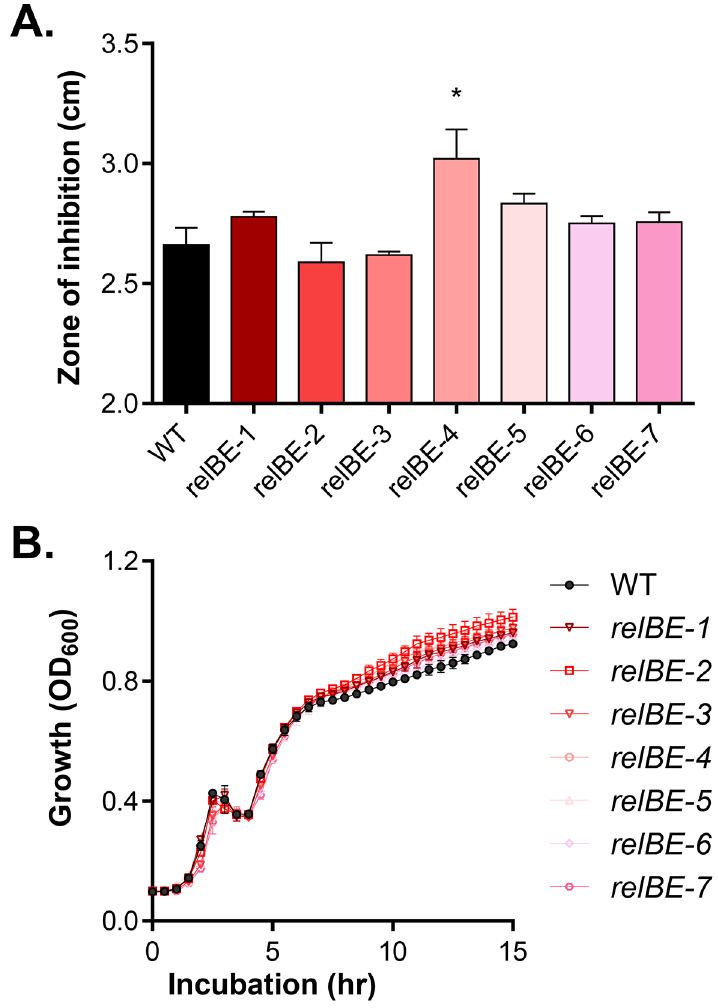
Fig 3. The effect of RelBE on V . cholerae resistance of stress. A. Disc assays for hydroperoxide resistance. Plates with indicated mutant in top-agar were incubated with a disc loaded with (5 M H 2 O 2 ) at 37°C for 16 hrs. The diameter of inhibition zone was then measured. Data are mean and s.d. of three independent experiments. * : P < 0.05. B. Bile resistance. Wild type and relBE mutants were inoculated 1:100 into LB containing 0.02% crude bile (Sigma, Co) and incubated at 37°C. OD 600 was measured. Data are mean and s.d. of three independent